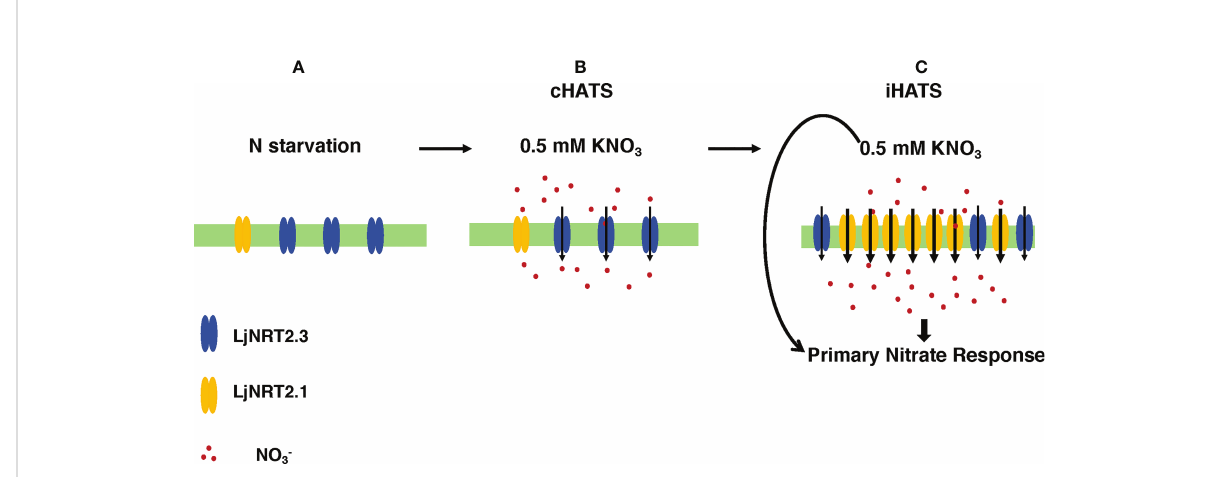
FIGURE 7 Hypothetical model of the combined action exerted by LjNRT2.3 and LjNRT2.1 to achieve the iHATS and the primary nitrate response after prolonged N starvation conditions. Plasma membrane localization and uptake activity of LjNRT2.3 are based on data reported for the orthologous AtNRT2.5 (Kotur et al., 2012; Lezhneva et al., 2014). (A) Induction of LjNRT2.3 under N starvation conditions. (B) LjNRT2.3 -mediated cHATS. (C) LjNRT2.1 -mediated iHATS and triggering of the primary nitrate response. Arrows in (C) indicate local and systemic nitrate-mediated signalling